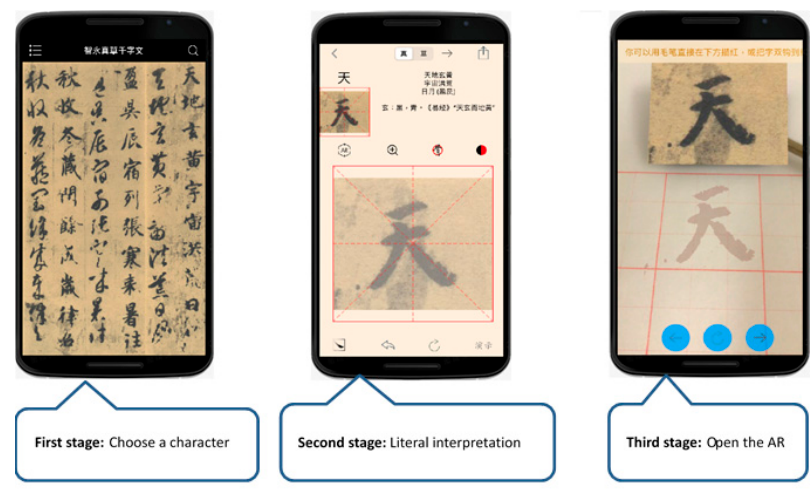
Figure 3. The experimental group of elderly participants using calligraphy AR.